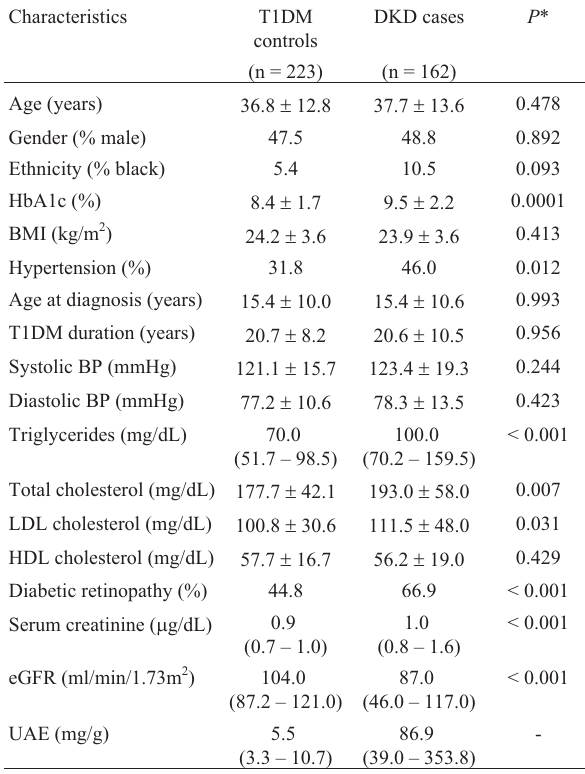
Table 1 - Clinical and laboratory characteristics of T1DM patients with UAE > 30 mg/24 h (DKD cases) and T1DM patients with UAE < 30 mg/24 h (T1DM